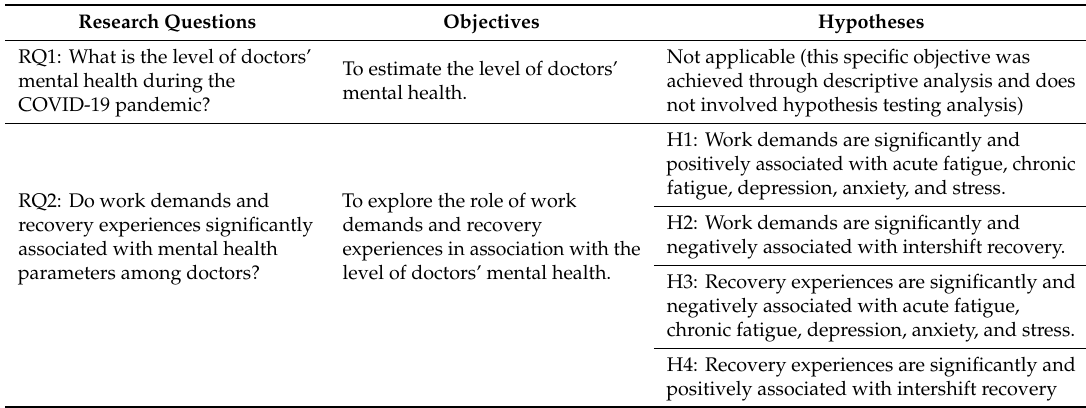
Table 1. Overview of research questions, specific objectives, and